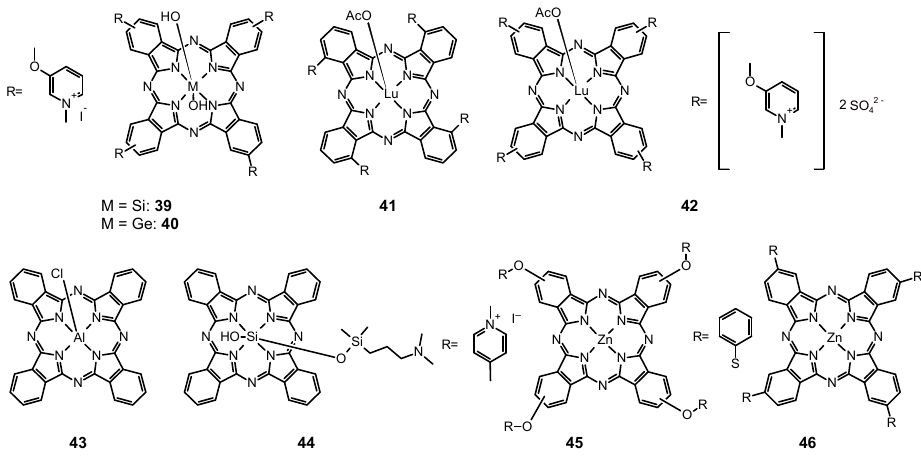
Figure 10. Chemical structures of ( 39–46 ) .